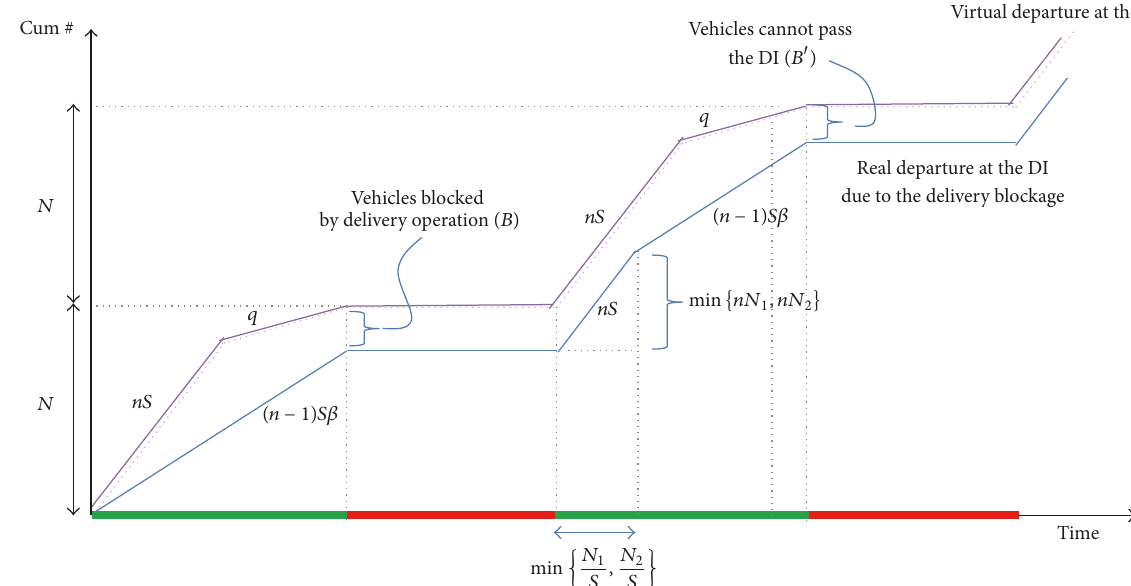
Figure 4: Virtual departure and real departure curves at the DI for the cases where the service rate at DI is not affected.